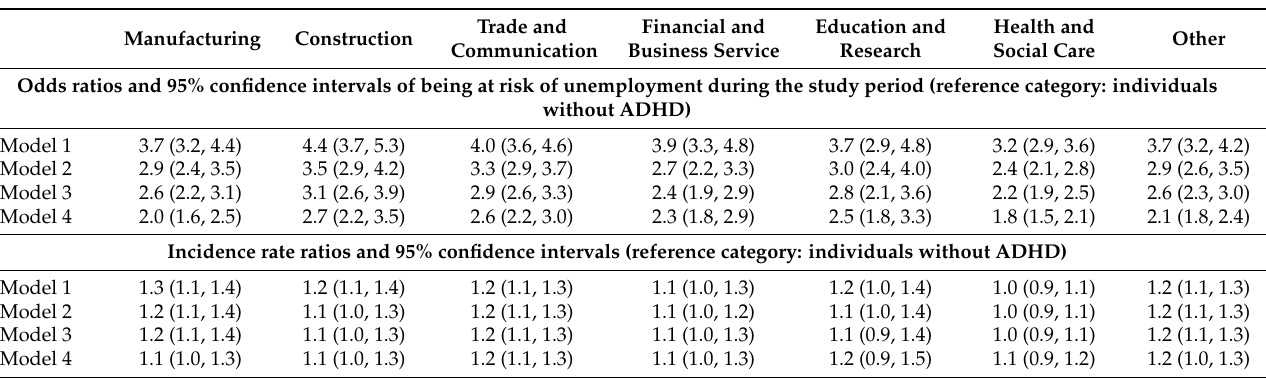
Table 4. Unemployment (UE) days by occupational branches among young employed individuals with and without attention deficit hyperactivity disorder